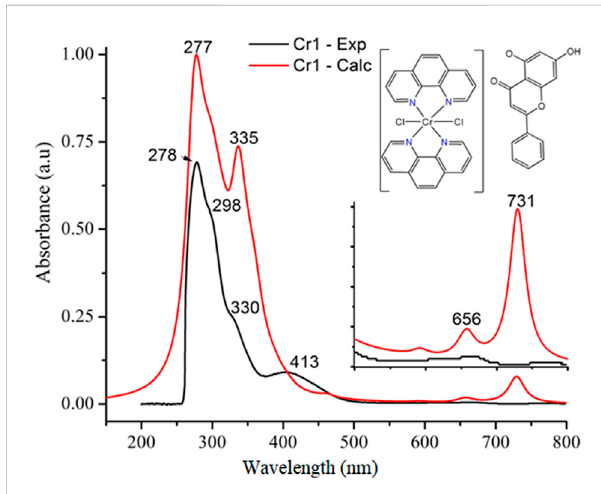
FIGURE 1 Experimental- (black) and TD-DFT-calculated (red) UV-Vis absorption spectra of Cr1 .